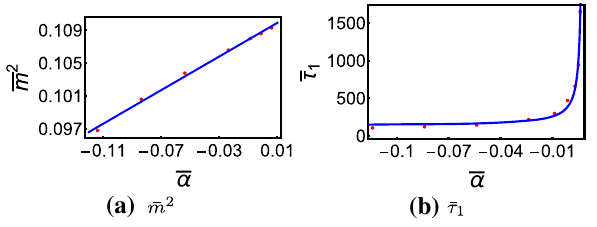
Fig. 13 The effects of the parameter ¯ α on the mass square ¯ m 2 and the lifetime ¯ τ of the first KK resonance for case 1. Red dots are numerical results, blue solid lines are fit functions. In the left panel the fit function is ¯ m 2 = 0 . 102 ¯ α + 0 . 109, in the right panel the fit function is ¯ τ 1 = + 131 . 621 1 0 . 00335 − 0 . 447 ¯ α